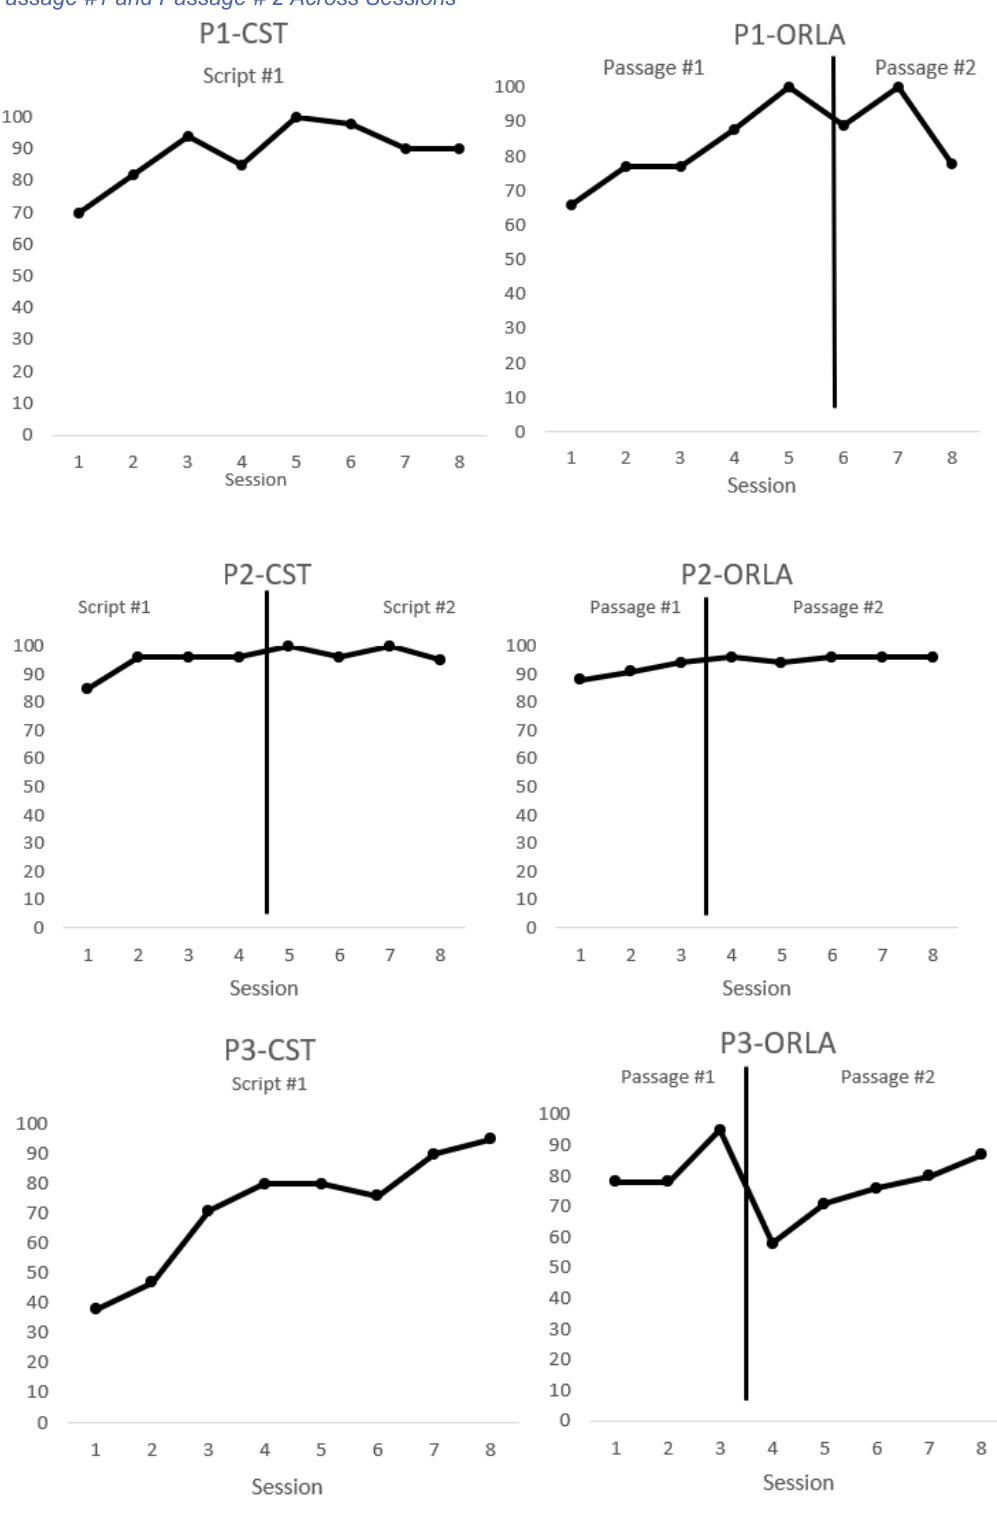
Figure 4 Individual Participant Treatment Data for Percentage of Total Words Correct for CST Script #1 and Script # 2 and ORLA Passage #1 and Passage # 2 Across